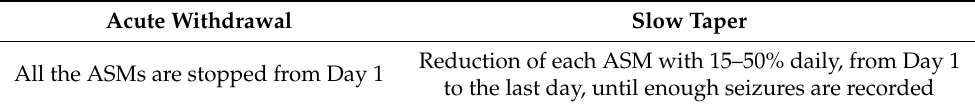
Table 1. Antiseizure medication withdrawal/taper